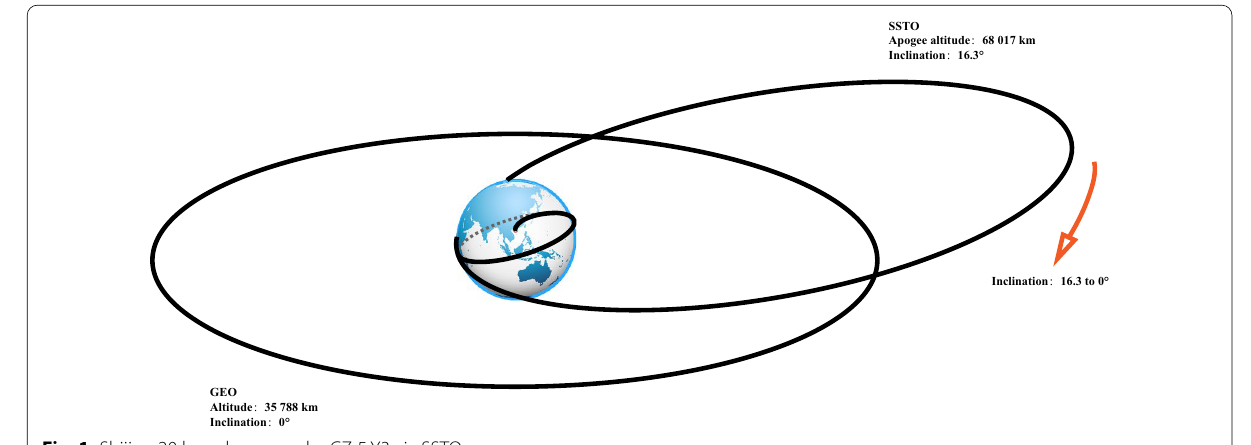
Fig. 1 Shijian-20 launch process by CZ-5 Y3 via SSTO